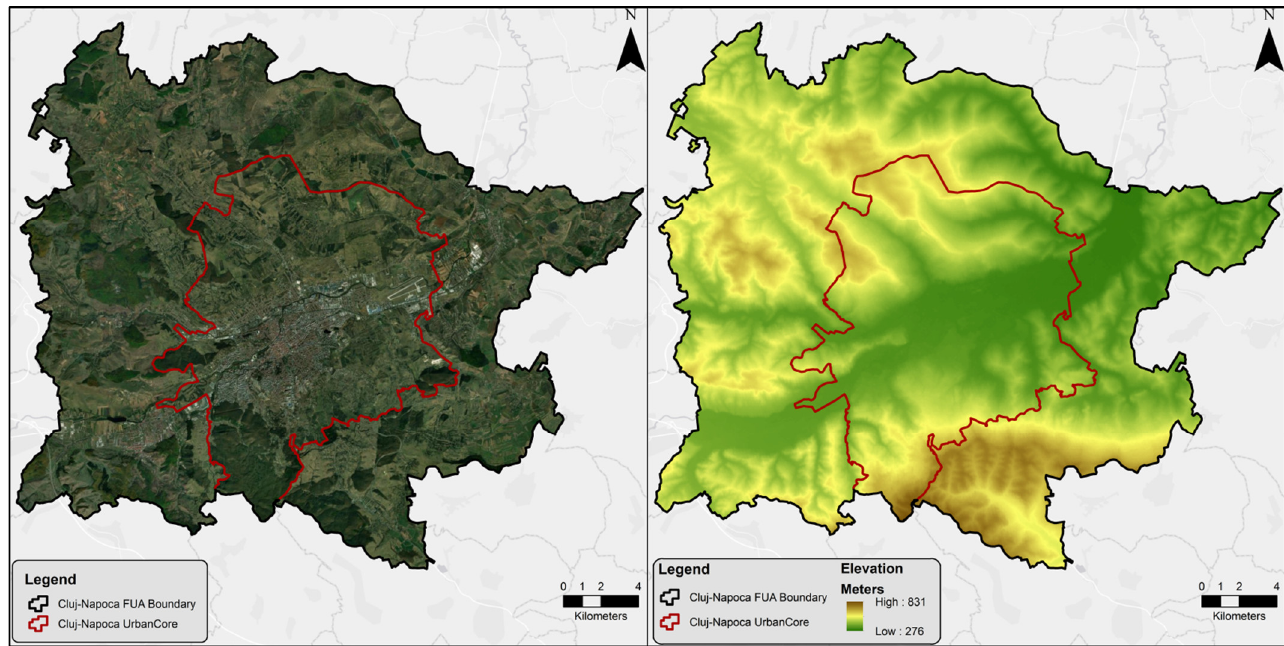
Figure 2. Satellite imagery- true color ( left ) and digital elevation model ( right ) for the 1st case study: Cluj-Napoca.